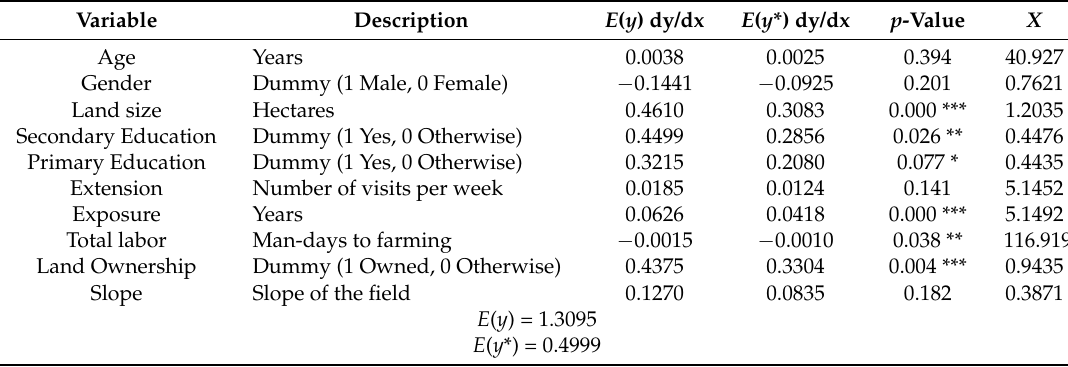
Table 6. Decomposition effect of the Tobit